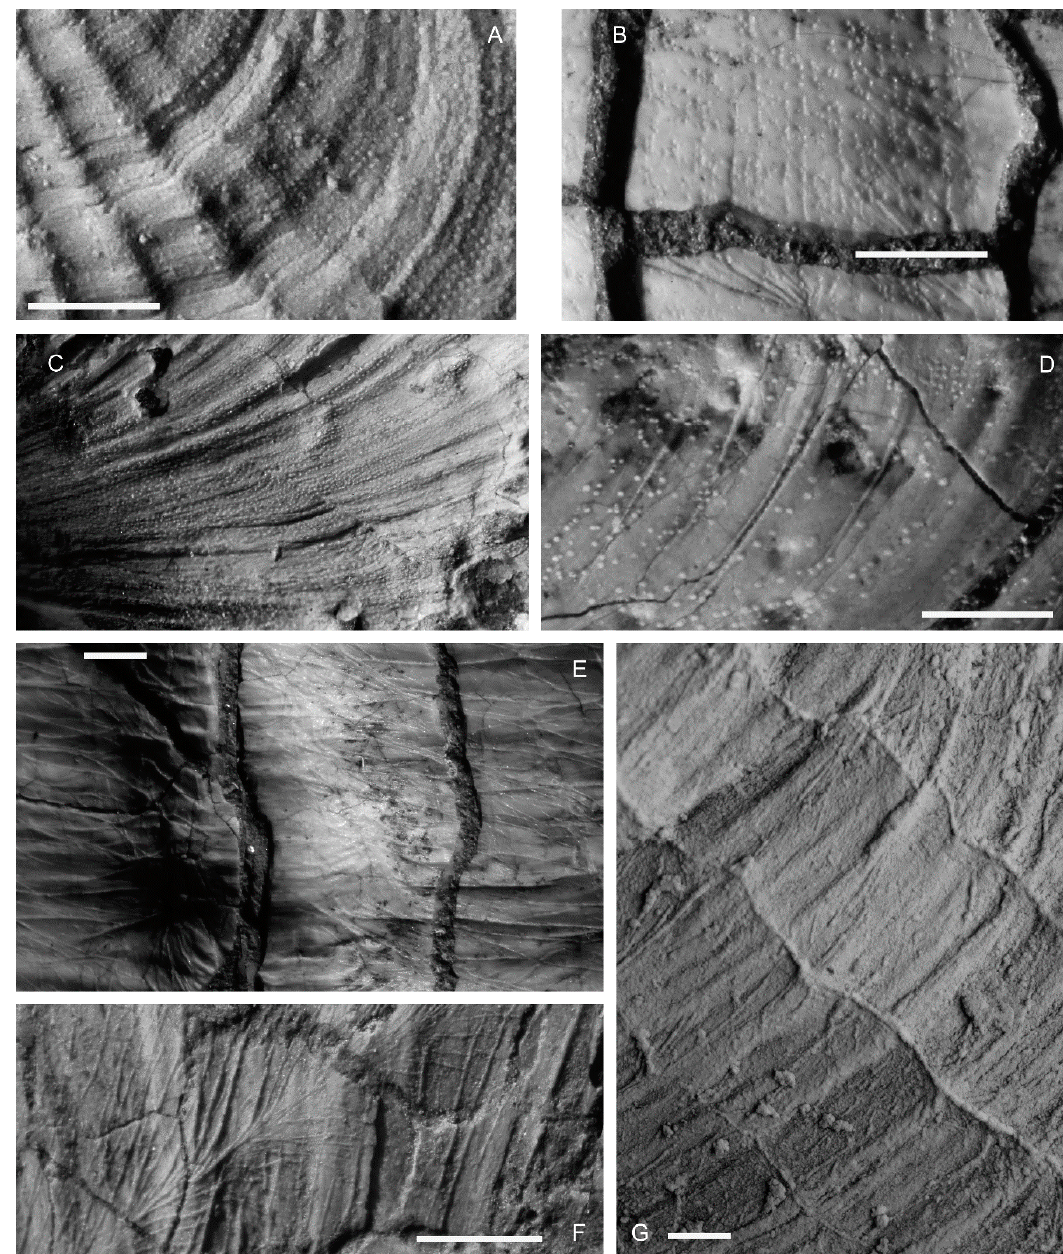
Figure 2. Microornaments. ( A ), Regular, radial rows of spikes. Pholadomya fidicula , Upper Bajocian Cz˛estochowa (specimen MGUS.Sz.3880). ( B ), Spikes in radial, irregularly spaced rows. Draperies visible in the lower part of the photograph. Ph. lirata , Middle Bathonian, Cz˛estochowa (MGUS.Sz.3733). ( C ), Spikes evenly and densely spaced, but not arranged in rows. Ph. latirostris , Middle Bathonian, Ogrodzieniec (MGUS.Sz.3560). ( D ), Spikes sparse and chaotically distributed. Ph. latirostris , Middle Bathonian, Cz˛estochowa (MGUS.Sz.3757). ( E ), Draperies on a rib. (Same as in ( B )). ( F ), Draperies around a capillary rib. Ph. concatenata , Lower Bathonian, Faustianka (MGUS.Sz.3558). ( G ), Capillary ribs. Ph. latirostris , Lower Bathonian, Korwinów (MGUS.Sz.3571). Scale bar 1 mm.